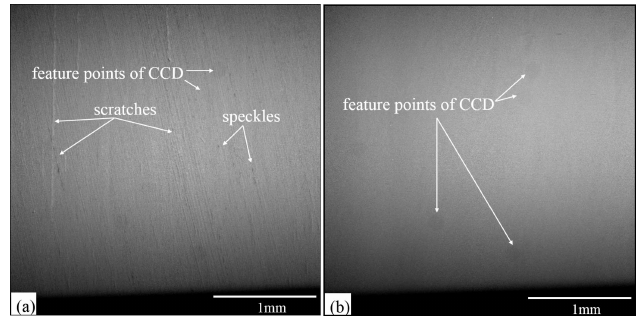
Figure 6 ( a ) Topography of the etching surface. Numerous scratches and speckles were introduced on the surface. ( b ) Topography of the polishing surface. The spot is balanced – a few dark points originate from the CCD.